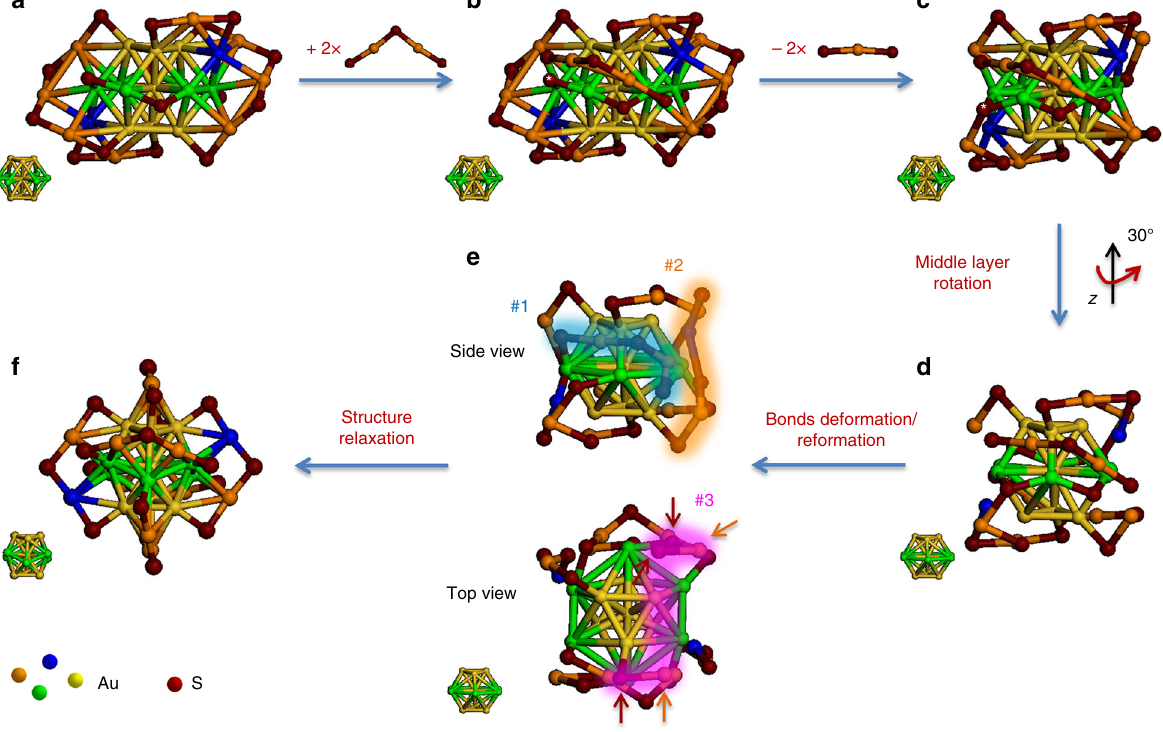
Fig. 4 Schematic illustration of size-conversion reaction dynamics. a Structure of [Au 23 (SR) 16 ] − , b association of 2 SR-[Au(I)-SR] 2 , c dissociation of 2 SR- Au(I)-SR, d core structure transformation, e surface rearrangement, and f structure relaxation to [Au 25 (SR) 18 ] − . SR denotes thiolate ligand. The hub atoms and middle layer of Au 13 core in [Au 23 (SR) 16 ] − are highlighted in blue and green, respectively, for easy identi fi cation. The formation of dimeric SR-[Au(I)- SR] 2 motifs #1 – #3 is shown by glowing belts in e , and the S atoms and Au atoms involved in the formation of such dimeric motif #3 are indicated by wine and orange arrows, respectively. The core structure at each step is shown at left bottom of each